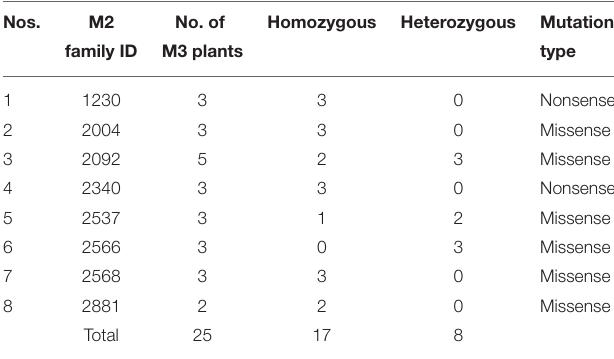
TABLE 1 | M2 families and single seed descent M3 plants with UGTS74S1 mutations from which M4 seeds were collected and used for phenotypic characterization of SDG lignan